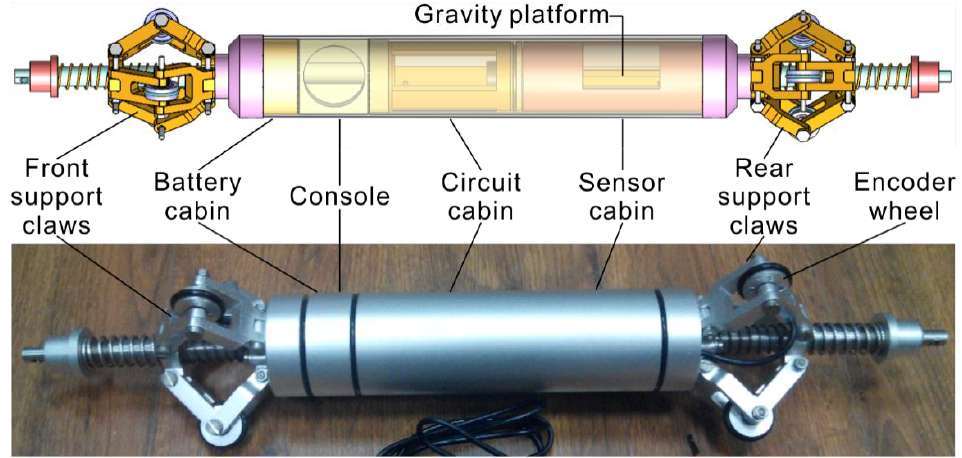
Figure 4. Mechanical structure of the pipeline track measurement system.